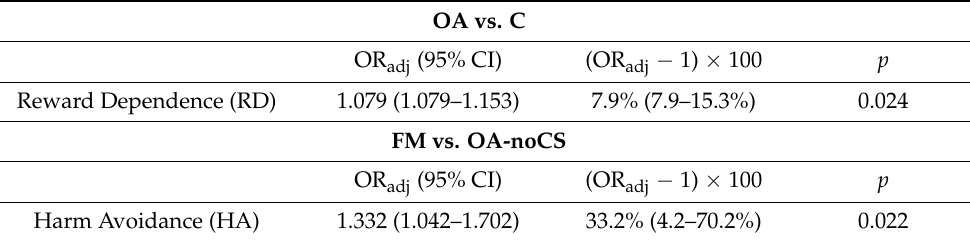
Table 4. Comparison between TCI-R personality profiles of patients with OA and the control